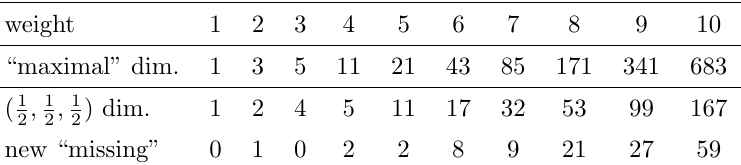
; 1 ; 1 ), for weights 2 2 2